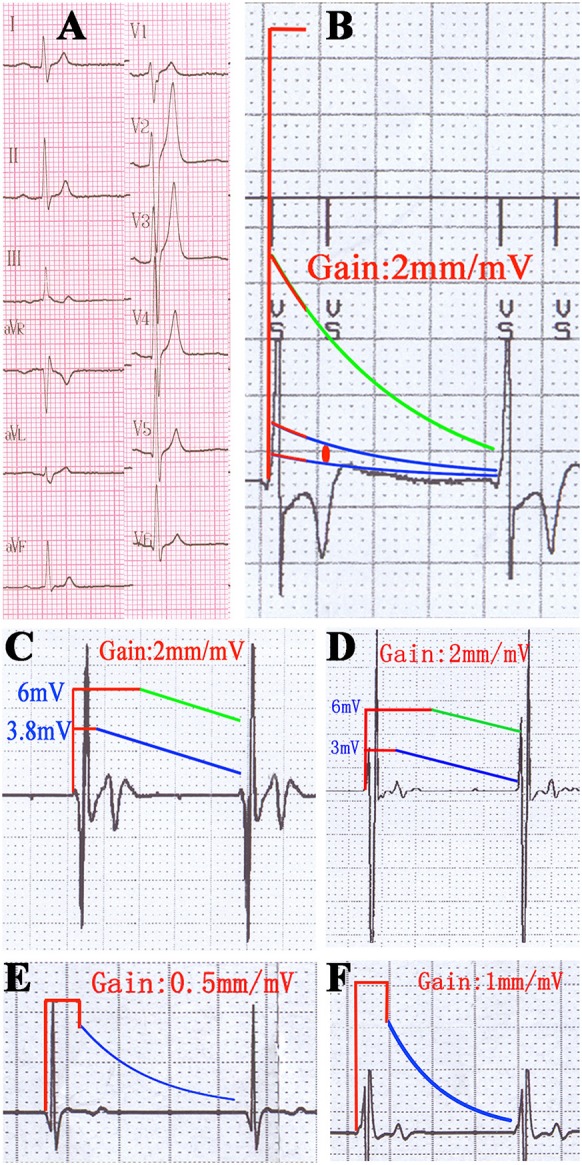
TWOS episodes during the procedure of ICD implantation and sensing threshold curves with real proportion. (A) 12-lead surface electrocardiogram of the short QT syndrome patient. (B) TWOS under the maximum sensitivity in Virtuoso ICD. Red line shows the blank period after sensing; green line shows the sensing curve with minimum sensitivity; blue lines show sensing curves with sensitivity of 0.3 and 0.15 mV; red dot shows the possible range of T wave amplitudes. (C) Intermittent TWOS under maximum sensitivity in Epic ICD. Green and blue lines show the sensing curves with minimum and default sensitivity, respectively. (D) Measurement of TWSM in Fortify ICD. (E,F) Measurement of TWSM in Vitality and Teligen ICDs. Blue lines show the sensing curve with default sensitivity.